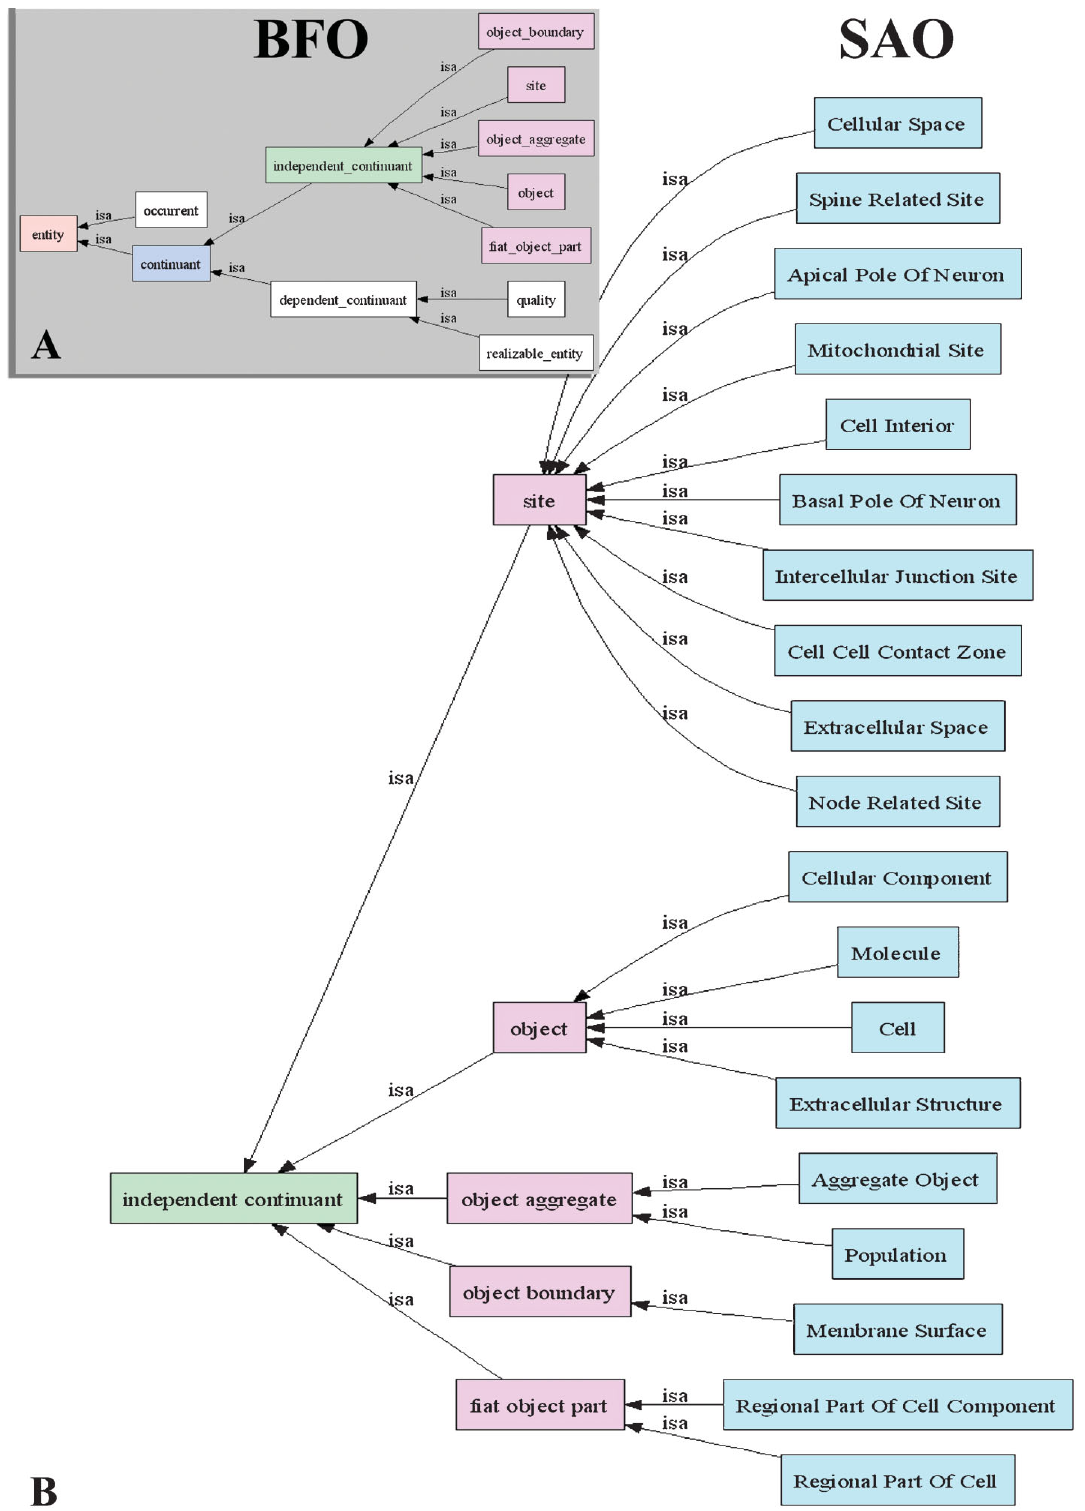
Figure 2. High level class structure of the SAO . The BFO entities are shown in ( A ) and in the green and pink boxes in ( B ). Spatial regions, subclasses of occurrents, and subclasses of realizable entity have been omitted because the SAO does not currently use them. SAO classes that are under the BFO hierarchy are shown in blue in ( B